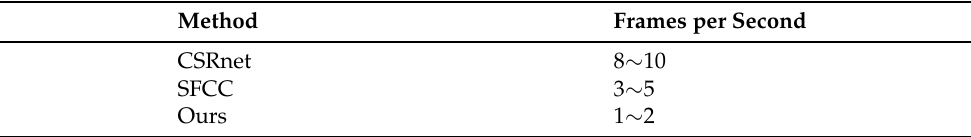
Table 4. Real-time analysis in the inference